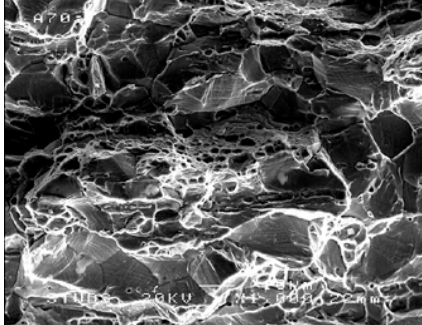
Figure 6. IG and ductile dimpled fracture of pin-loading tension specimen of a flux thimble tube (FTT), made from cold drawn A316, irradiation to 65 dpa in a PWR; fracture toughness test in air at room temperature [20]. Reproduced with the courtesy of A. Jenssen and Société Française d’Énergie Nucléaire (SFEN).